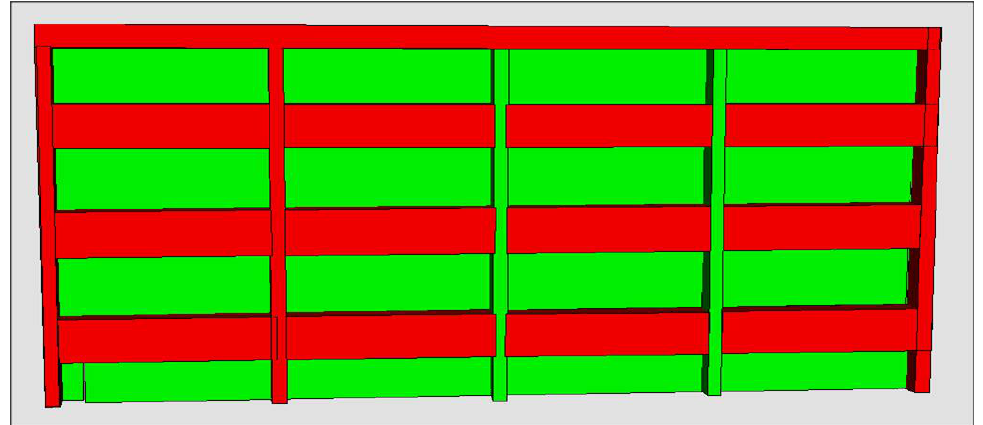
(b) Automatic reconstruction of a multi-floor building model with Rule Set 3 . Only determined model elements are displayed.